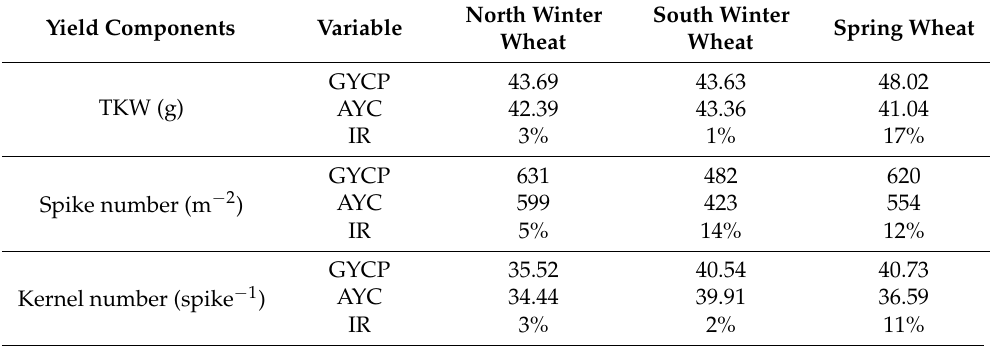
Table 4. Genetic yield component potential and average yield